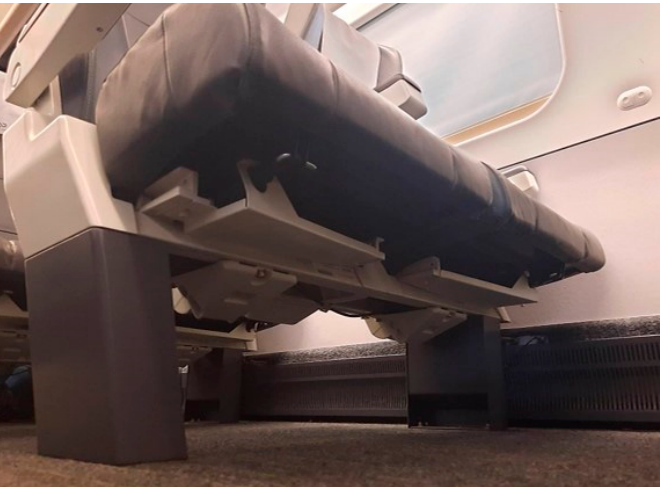
Figure 5. Seat metallic